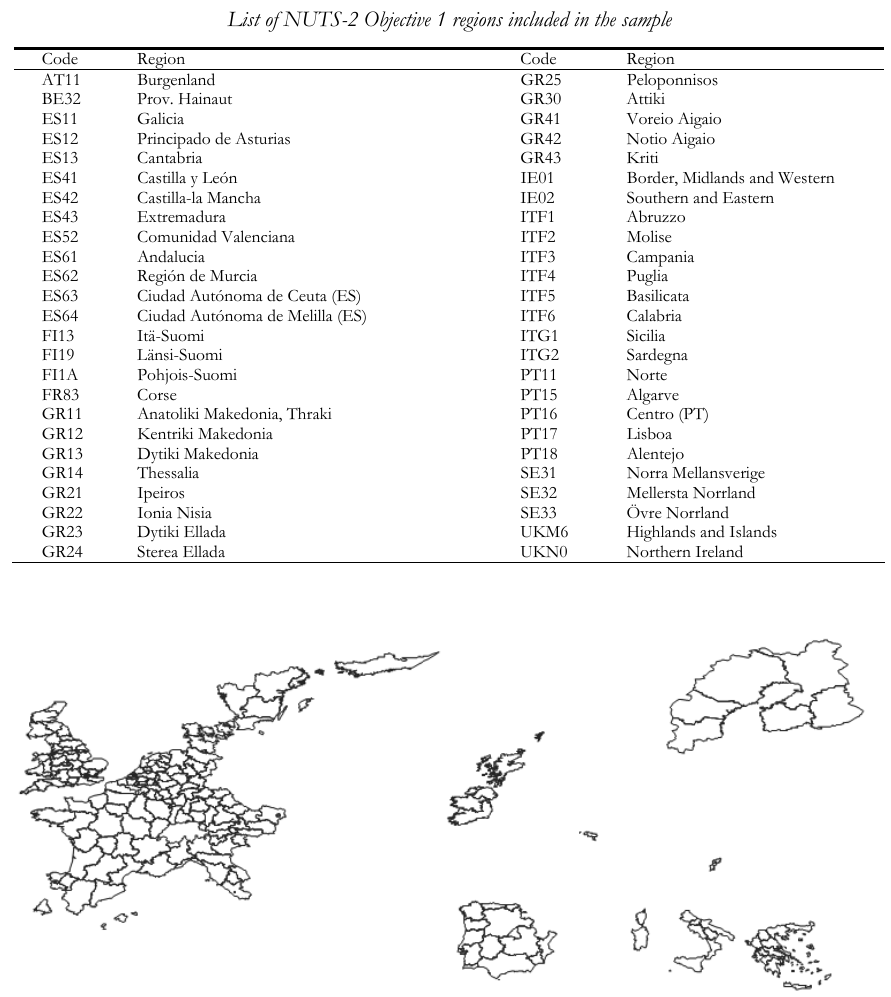
Figure A.1 – Maps of NUTS-2 non-Objective 1 regions included in the sample (left-hand panel) and Objective 1 regions included in the sample (right-hand